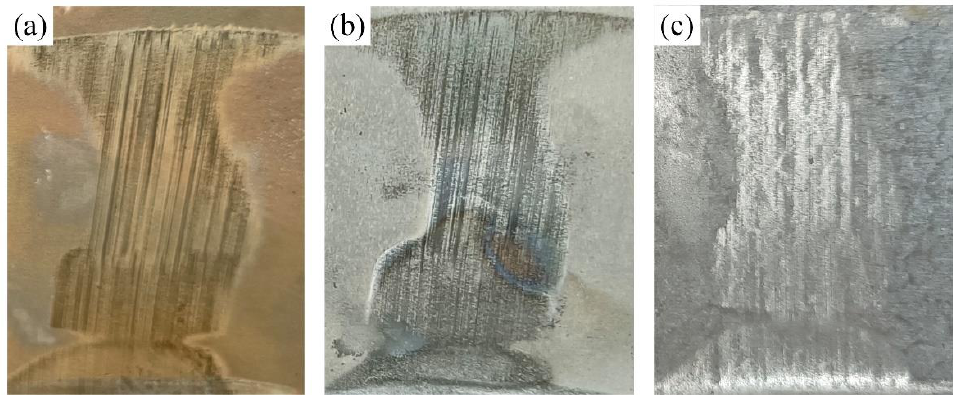
Figure 8. Enlarged views of coatings in region E: ( a ) region E in GA coating; ( b ) region E in GI coating; ( c ) region E in Al–Si coating.